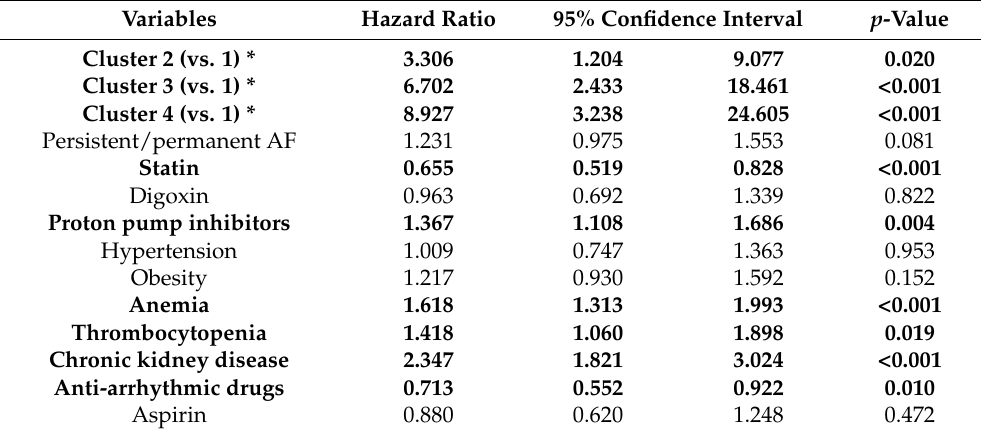
Table 2. Multivariable Cox proportional regression analysis of factors associated with